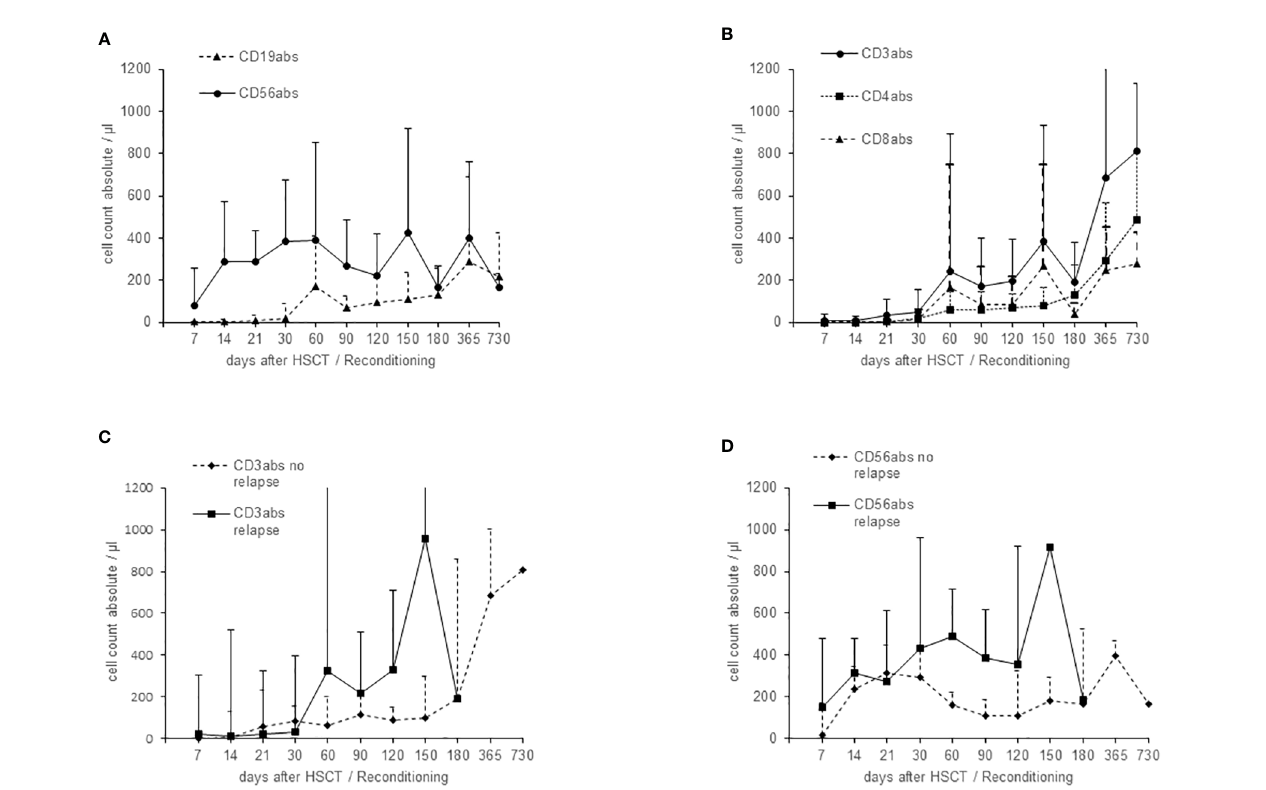
FIGURE 1 Immune reconstitution after haploidentical HSCT (mean and standard deviation), calculated from total lymphocyte cell count and fl ow cytometry results. (A) Reconstitution of CD56+ NK and CD19+ B cells. (B) Reconstitution of CD3+ T cells (CD4+ and CD8+). (C) Comparison of the recovery of CD3+ T cells in patients with or without relapse. (D) Comparison of the recovery of CD56+ NK cells in patients with or without